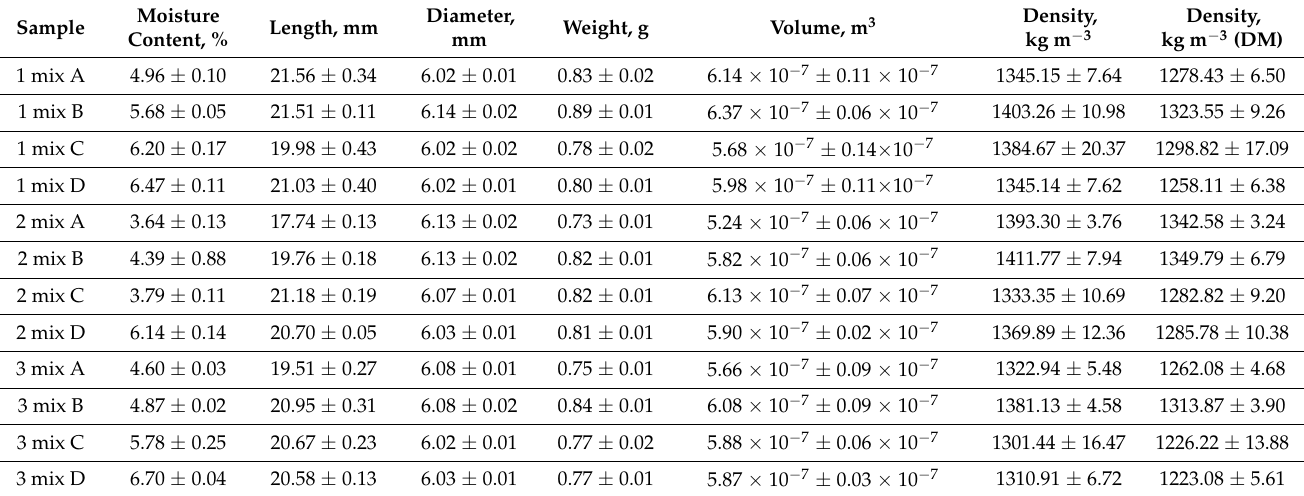
Table 3. Biometric properties of pellets.